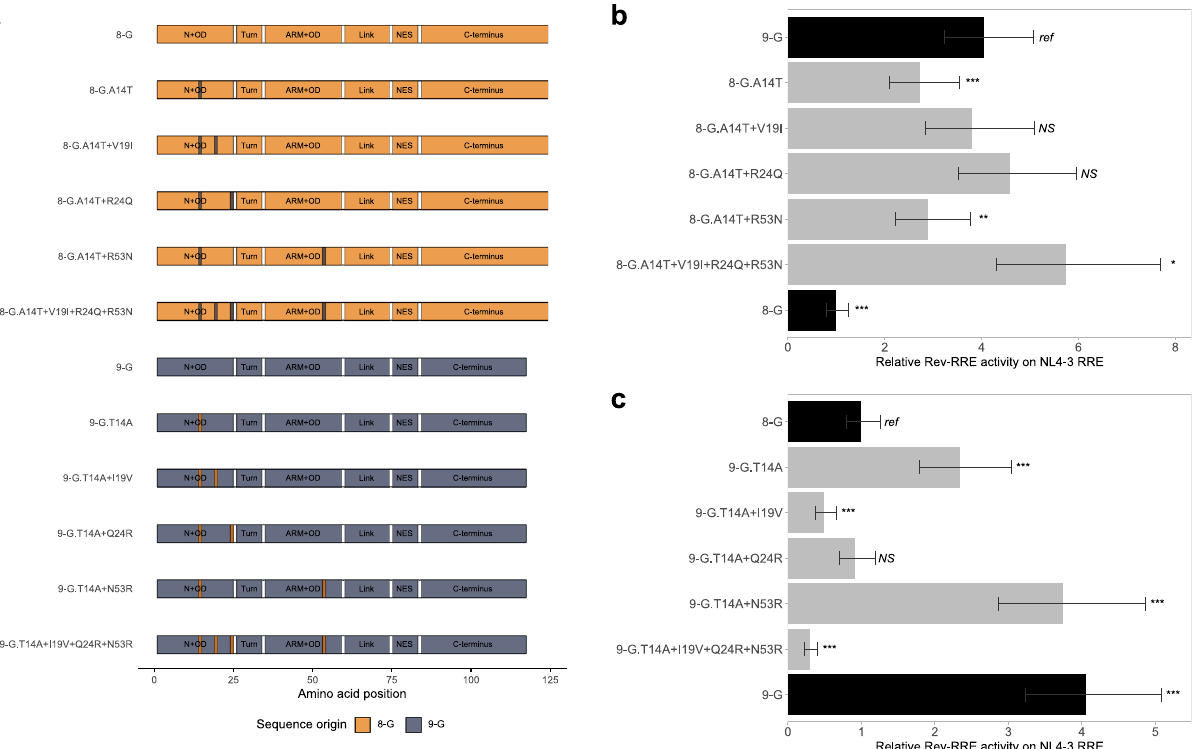
Figure 5. Activity of Revs with multiple amino acid substitutions on NL4-3 RRE. 8-G and 9-G Revs with multiple amino acid substitutions were created. A schematic of each Rev used in this set of experiments is shown in ( a ). Single amino acid substitutions are shown as a vertical bar on contrasting color at the indicated location. The functional activity of 8-G ( b ) and 9-G ( c ) constructs on the NL4-3 RRE using the fluorescence-based assay system is shown. In each plot, the native 8-G and 9-G Rev sequences are included in dark bars for reference and modified Revs are in light bars. For both plots, relative activity is expressed in arbitrary units with the activity of the 8-G Rev/NL4-3 RRE pair defined as 1. The statistical comparison is performed in reference to the top-most Rev in each plot. N ≥ 3 for all data points, error bars represent 95% CI. N + OD—N-terminus plus first portion of the oligomerization domain, ARM + OD – arginine rich motif plus second portion of the oligomerization domain, NES—nuclear export signal. Ref —reference sequence for the plot, NS —not significant, *** p < 0.001, ** p < 0.01, * p <